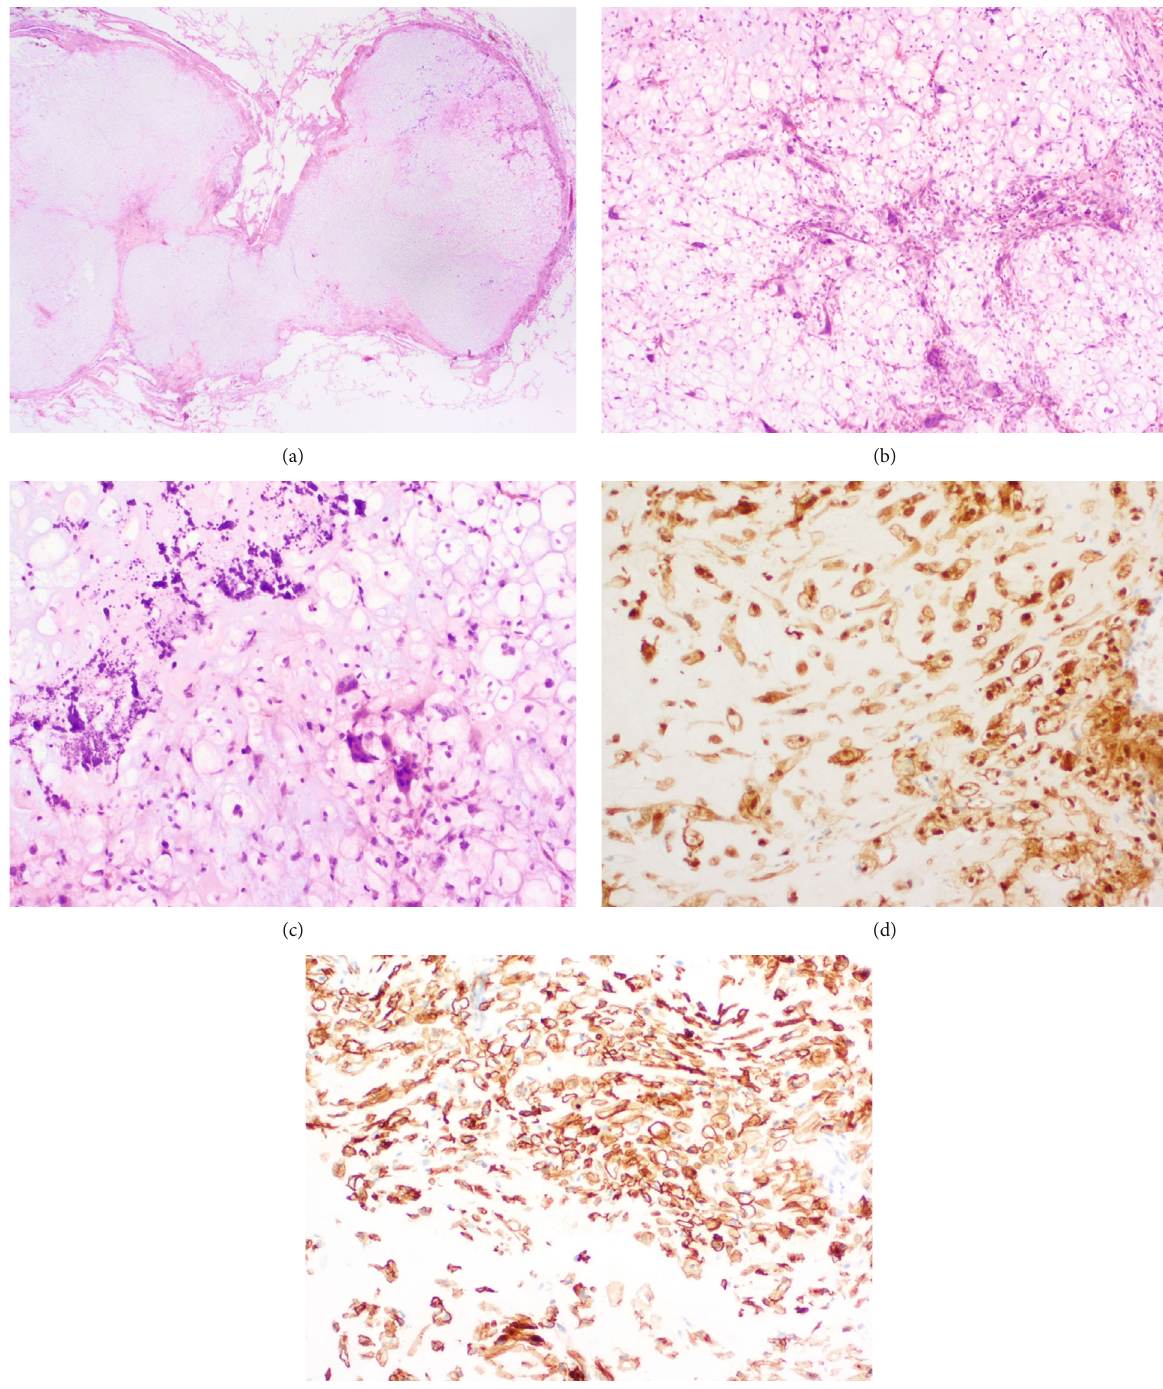
Figure 3: Lung metastasis. Histology of the wedge resection of the left upper lung lobe showing a 15 mm large, well-circumscribed chondroid tumoral lesion (hematoxylin and eosin, original magni fi cation 12x (a)). Atypical rounded cells with a centrally placed, large round nucleus and abundant clear cytoplasm (hematoxylin and eosin, original magni fi cation 100x (b)). Presence of osteoclast-like giant cells, a chondroid matrix, and calci fi cations (hematoxylin and eosin, original magni fi cation 200x (c)). Di ff use expression of the tumor cells for S100 (original magni fi cation 200x (d)) and Podoplanin (D2-40) (original magni fi cation 200x